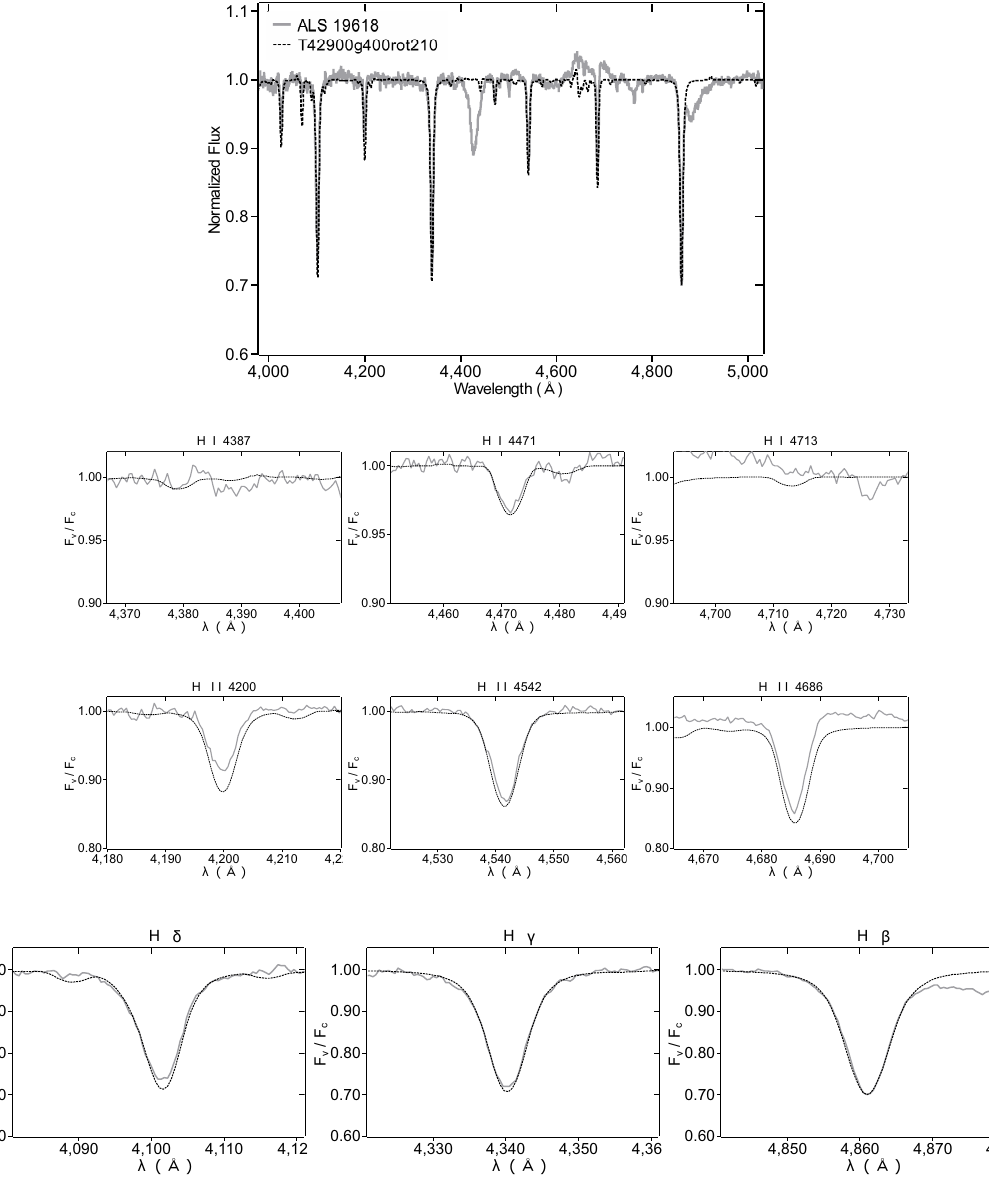
Fig. 1 Best fit (black dotted line) of the observed (gray line) of ALS 19618.The upper figure shows the whole fit to the blue-violet spectrum, The lower figure shows detailed fits for the standard diagnostic lines of He and H . The effective temperature is 42900 K, log g = 4 . 00 and vsini =210 km s − 1 . surface gravity 4 . 0 ± 0 . 1.the fit with the model performed higher rotational velocity for ALS 19618 ( vsini = 210 ) and ( vsini = 150 ) for BD+50886.The physical parameters of this study are displayed in Table 2.